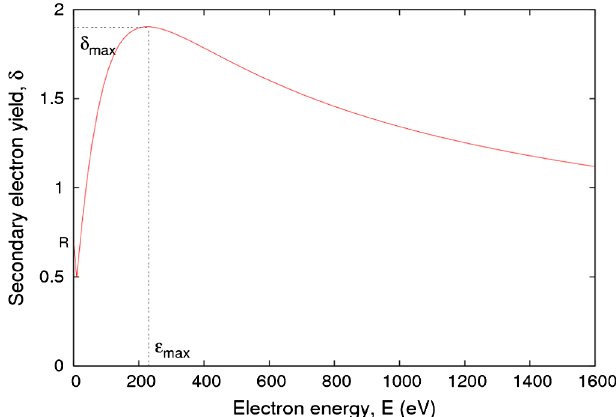
FIG. 1. Secondary emission yield as a function of primary electron energy, defining the parameters (cid:1)